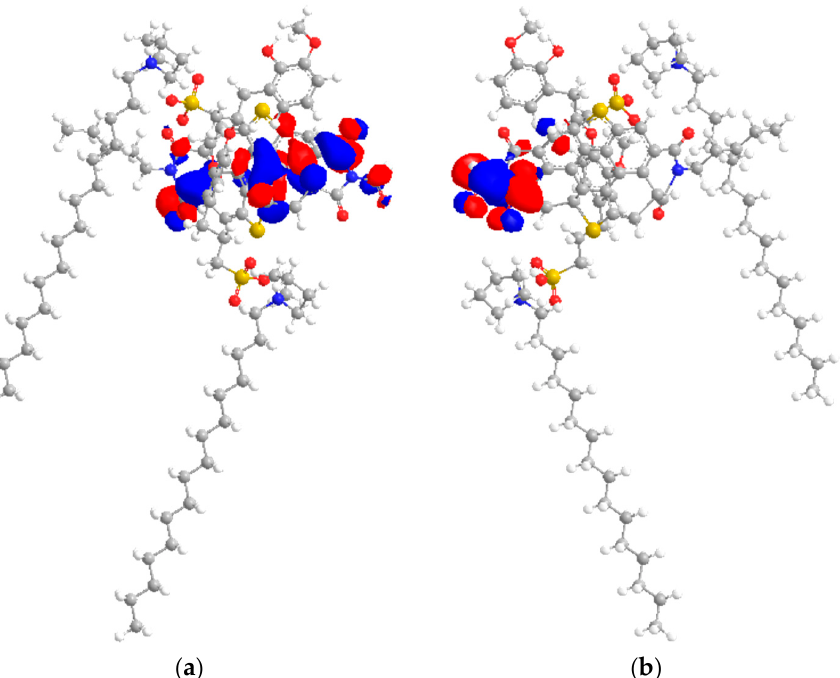
Figure 14. ( a ) HOMO location of asphaltene model; ( b ) LUMO location of asphaltene model [22,39]. Yellow, blue, grey, white and red respectively, represented sulfur, nitrogen, carbon,hydrogen and oxygen.